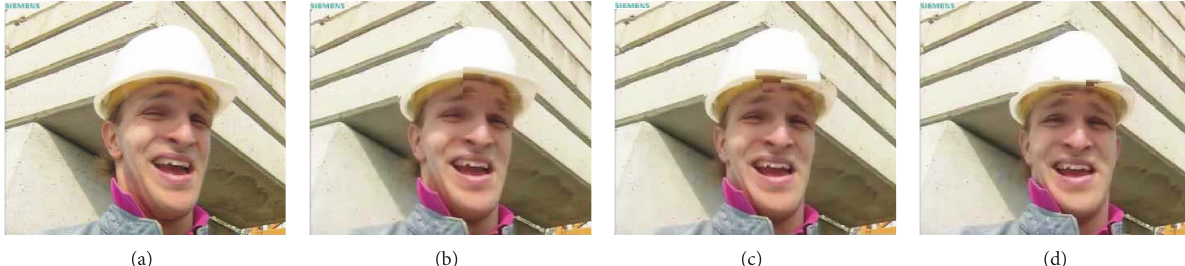
Figure 14: Packet loss affecting only one frame. (a) Original frame and (b, c, d) next three decoded frames.